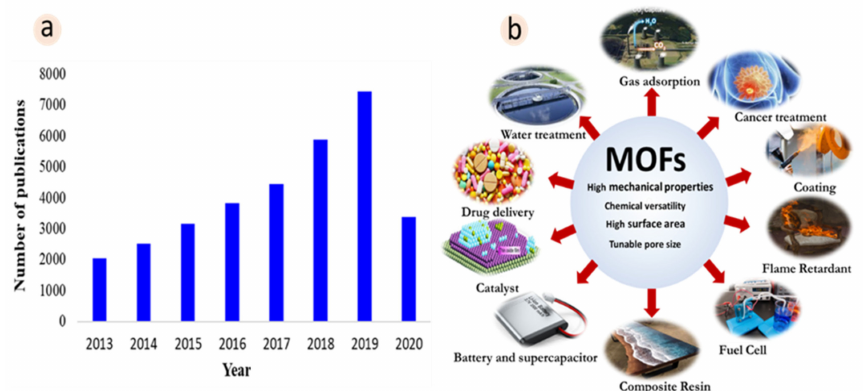
Figure 3. ( a ) The number of published articles related to MOFs in the period of 2013 to 2020 (Source: Scopus, April 28, 2020). ( b ) Some unique characteristics and various applications of MOFs (designed by the authors of the present